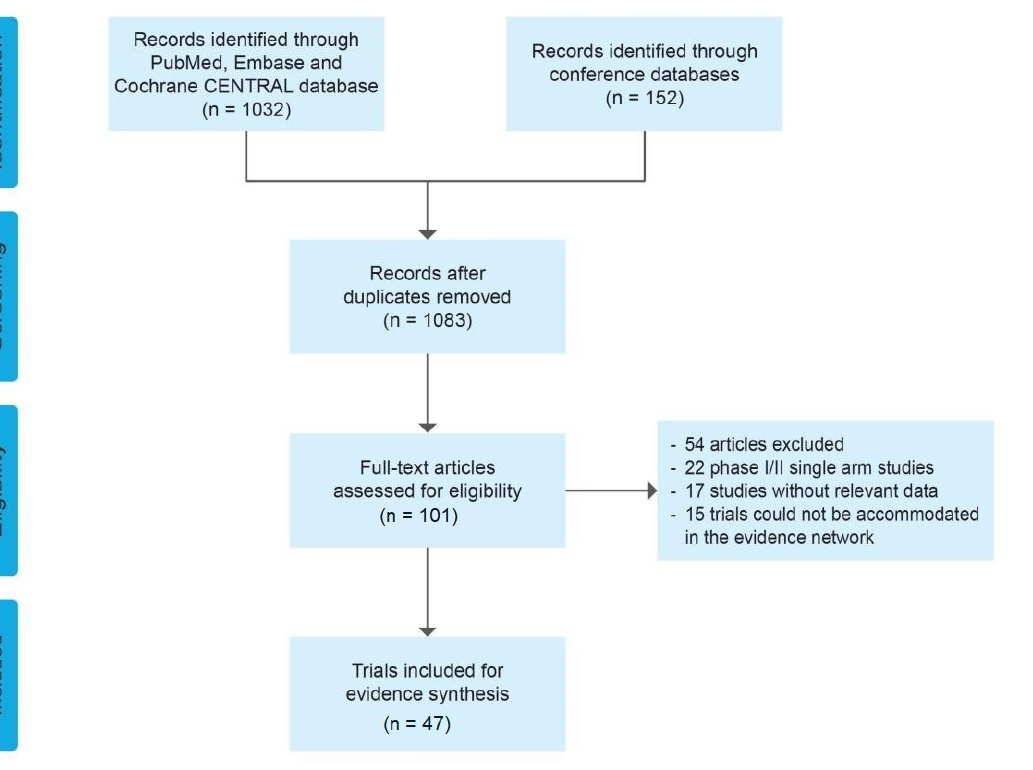
Figure 1. PRISMA flow chart. Table 1. Baseline characteristics of the included